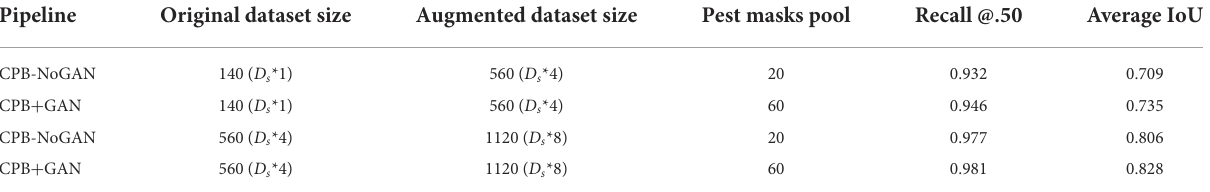
TABLE 2 PestNet test performances for different CPB configurations. Pipeline